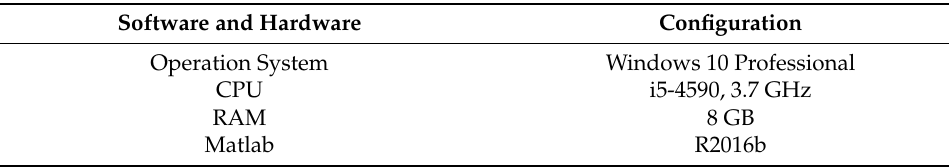
Table 1. Instructions for the computational platform.